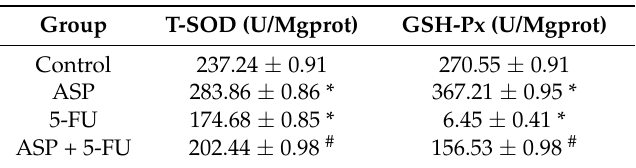
Table 2. Effect of ASP regulated injured HS-5 cells on oxidation resistance in human umbilical cord blood-derived hematopoietic cells(X ± S, n =